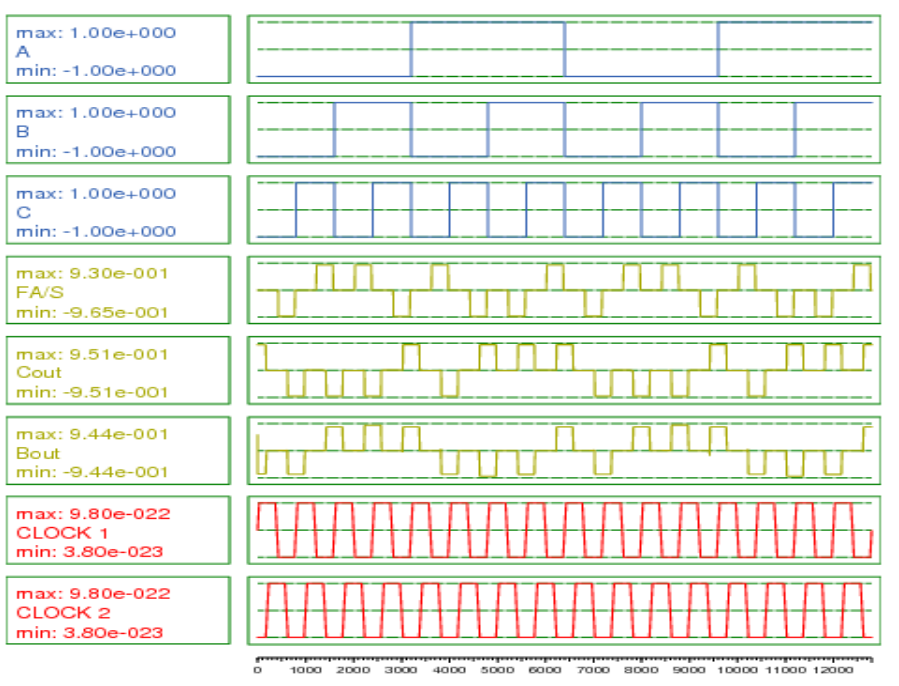
Figure 17. Simulation results for the proposed (A) Full Adder/Full Subtractor circuit.